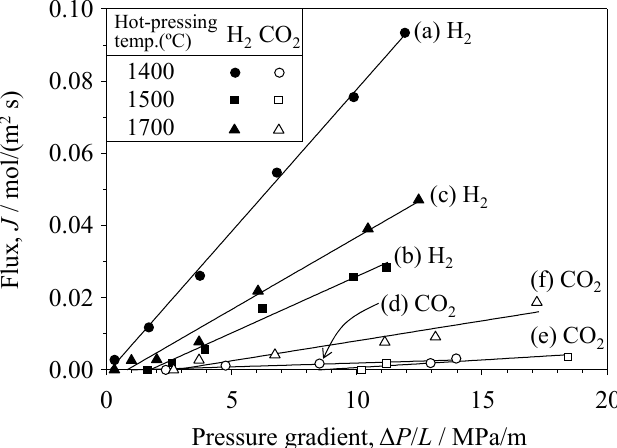
Figure 8. Single-gas flux of H 2 and CO 2 through porous SiC ceramics hot-pressed at 1400, 1500, and 1700 °C as a function of the pressure gradient.